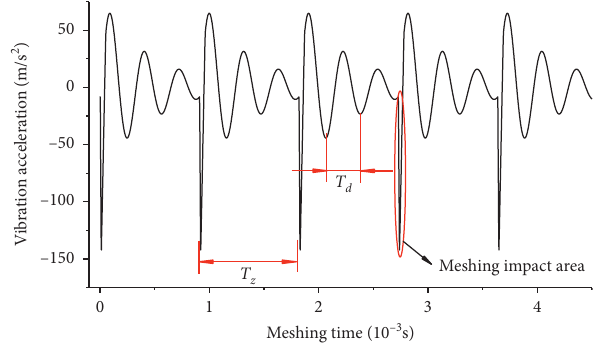
Figure 16: Time domain diagram of single-stage helical gear transmission under excitation of meshing impact at 3,000rpm.